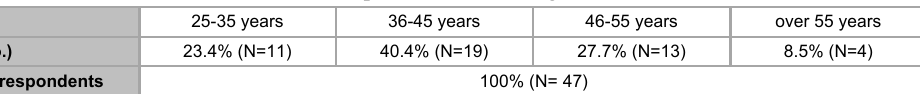
Distribution of respondents according to their